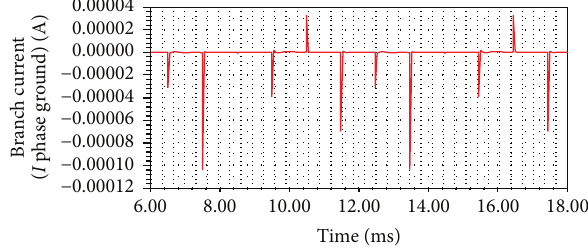
Figure 18: The inverter input current (with LCL filter and capacitor bank).